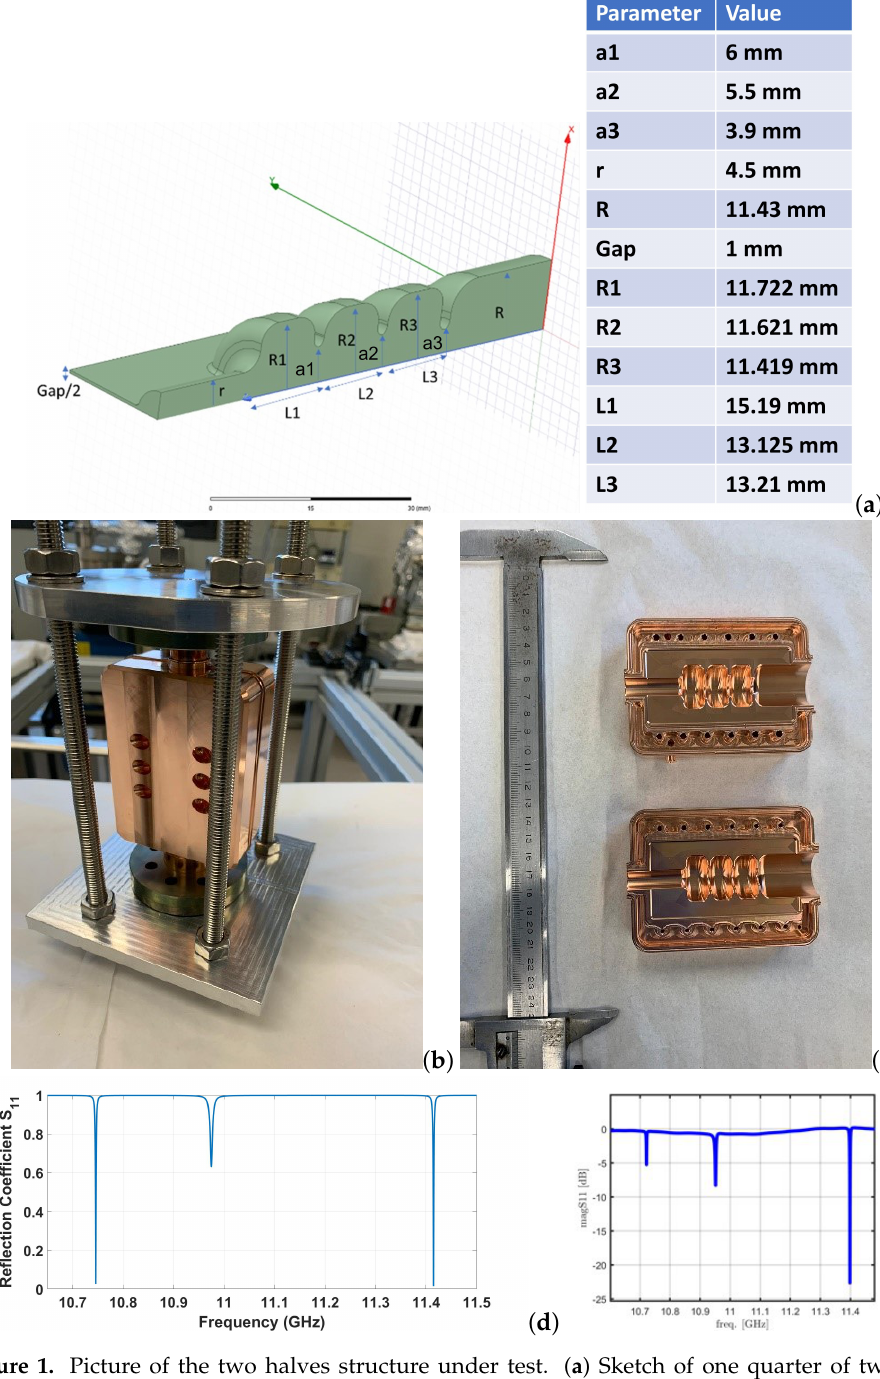
Figure 1. Picture of the two halves structure under test. ( a ) Sketch of one quarter of two half structures for simulation studies using ANSYS HFSS software ( b ) clamped structure for low-power tests; ( c ) two halves of the machining; ( d ) simulated structure frequency spectrum ( e ) measured frequency